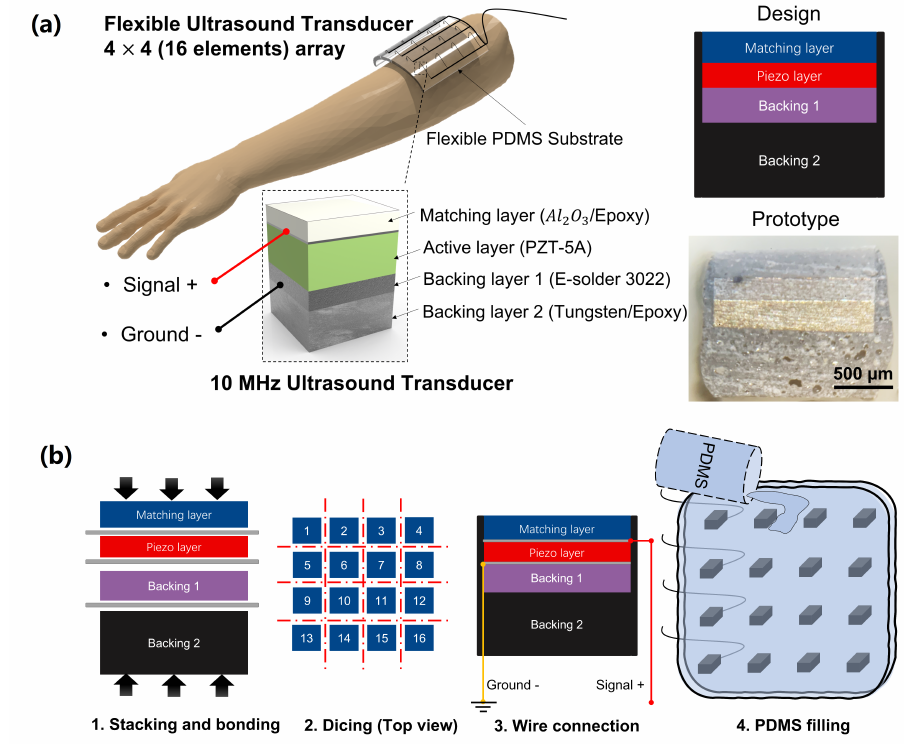
Figure 2. ( a ) Schematic demonstration of the wearable US transducer design. ( b ) The fabrication process for the wearable US transducer.